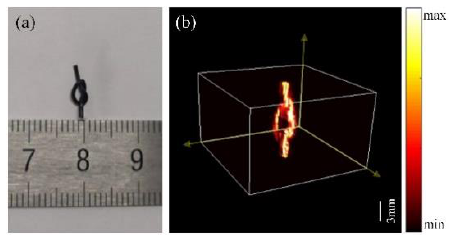
Figure 11. ( a ) Photograph of a knot phantom and ( b ) 3D photoacoustic image.